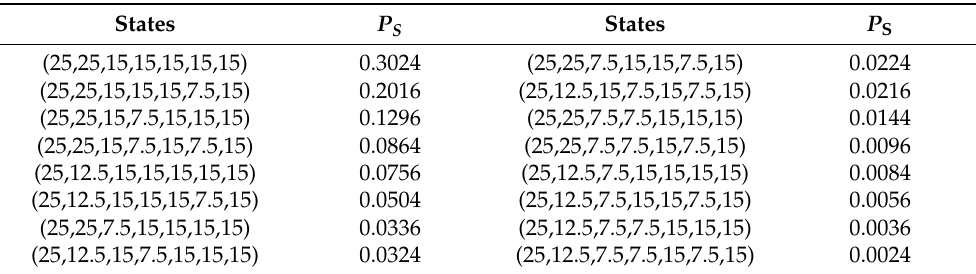
Table 2. State probability of different road network